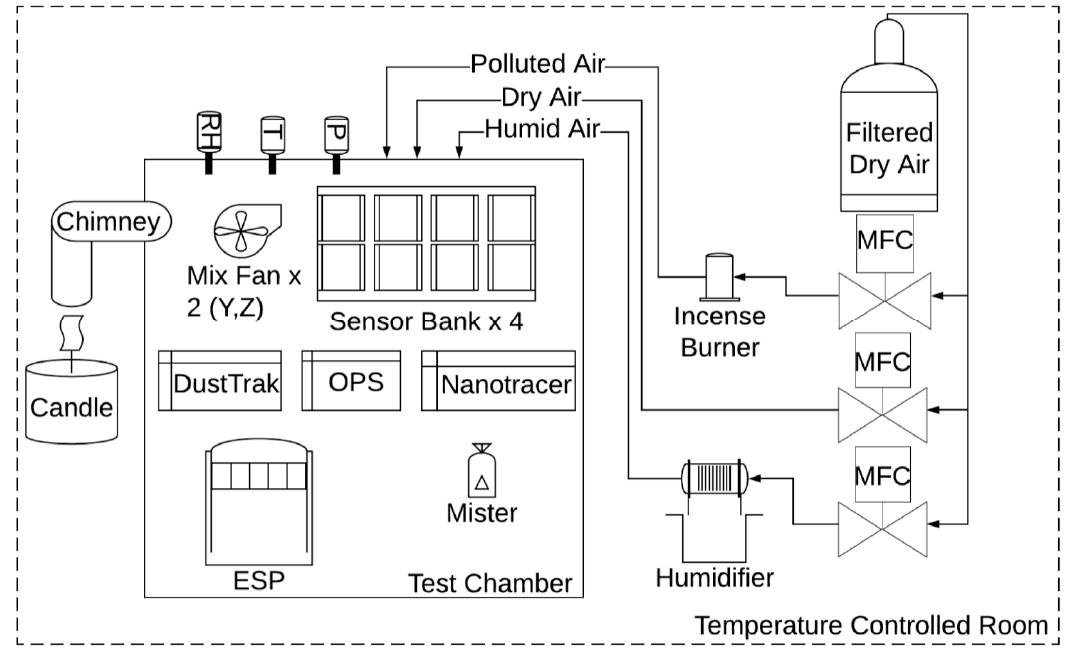
Figure 14. Schematic showing the arrangement of the test chamber and the supporting equipment (image reprinted under the terms and conditions of the Creative Commons Attribution (CC BY 4.0)